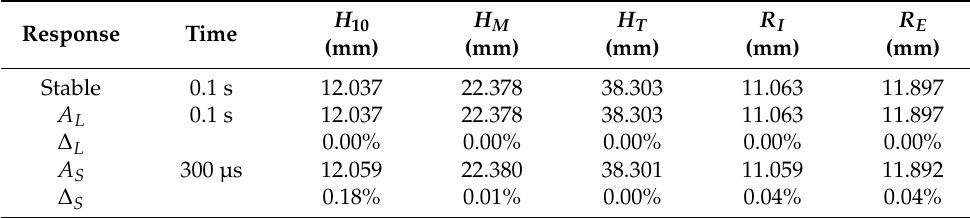
Table 1. Data processing results of the geometric parameters of the dynamic tensile test.